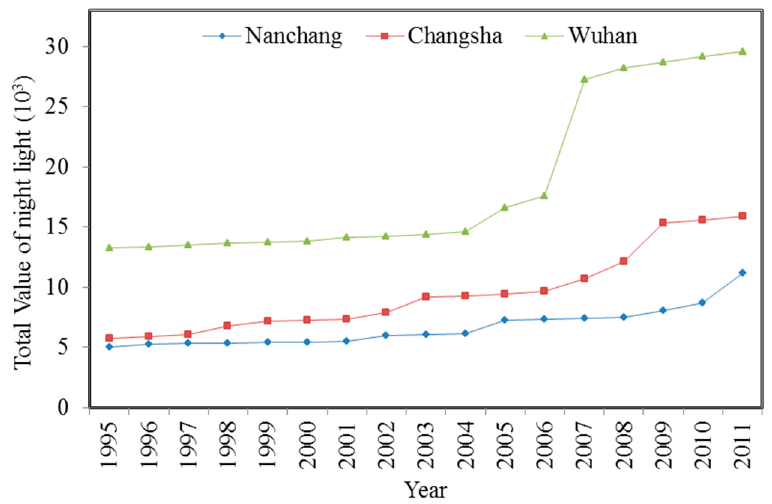
Figure 12. Temporal variation of NTL brightness for three provincial capital cities from 1995 to 2011.